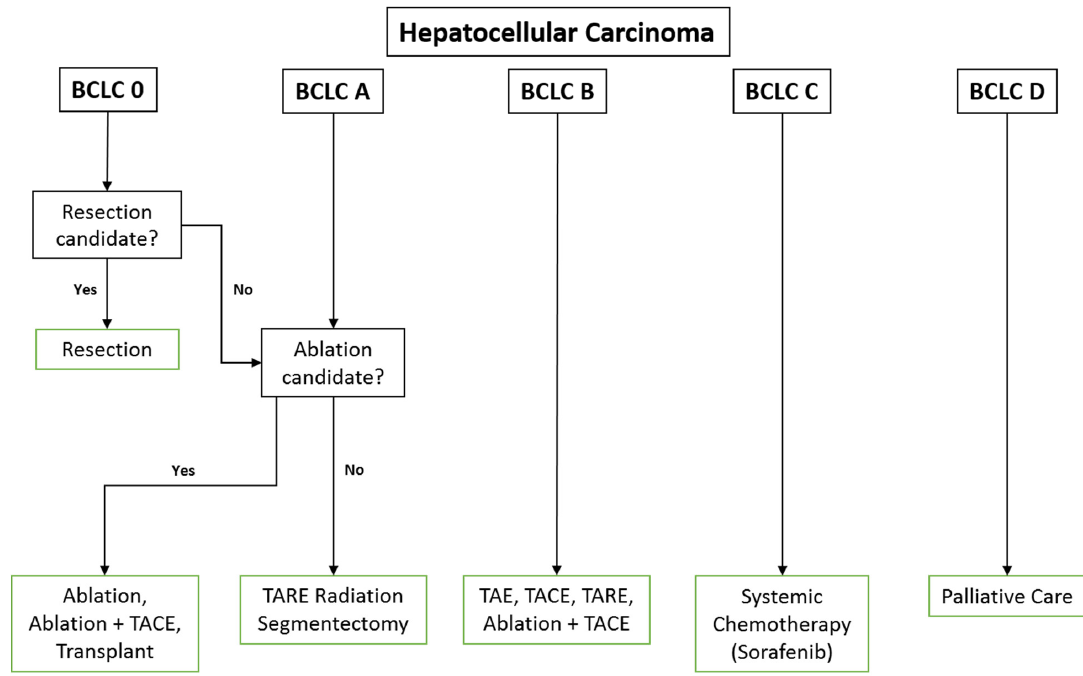
Figure 1. Treatment options for hepatocellular carcinoma stratified by BCLC class. Note that any locoregional approach can be used to maintain or downstage to transplant eligibility. Contraindications to resection include significant portal hypertension, hyperbilirubinemia, multiple nodules, and comorbidities. Contraindications to ablation include lesion > 5 cm, > 4 nodules, and anatomic infeasibility.